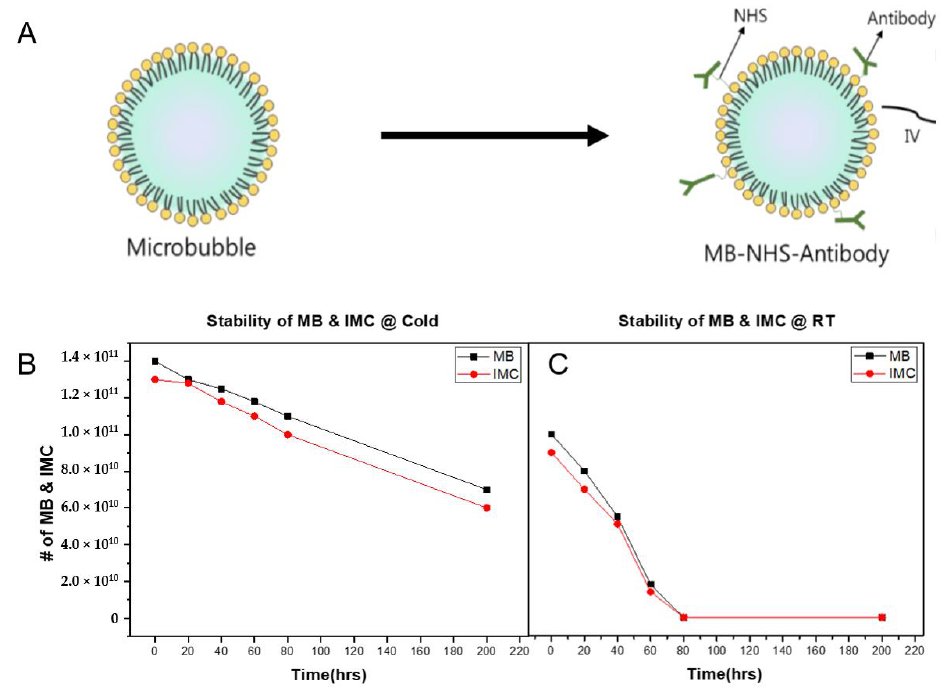
Figure 2. Synthesis of the immune-microbubble complex (IMC) and their stability. ( A ) The schematics of conjugating an- tibodies onto the surface of MBs using amine-NHS crosslinking. ( B ) The stability of the MBs and IMCs at 4 °C over 200 h. For both MBs and IMCs, up to 50% of the initial amount remained viable. ( C ) The stability of the MBs and IMCs decreased significantly at room temperature conditions, suggesting that higher temperature was associated with their decay.